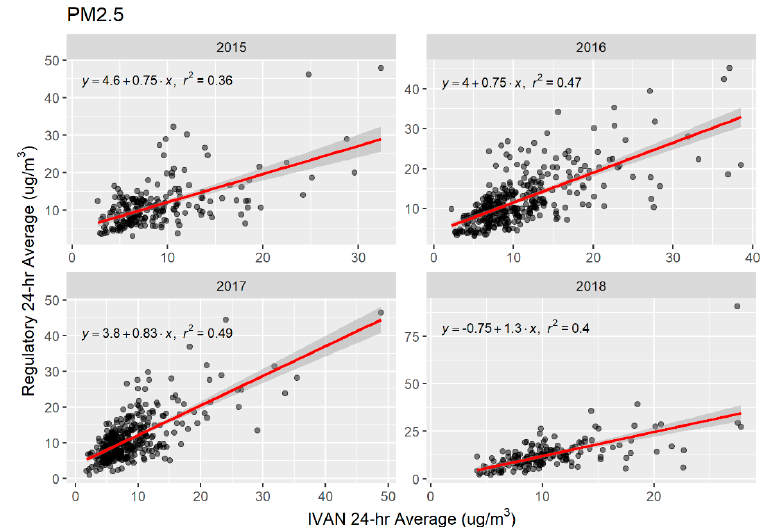
Figure 2. Scatter plots of mean 24-h averages of PM 2.5 from Community Network (IVAN) and regulatory monitors, 2015–2018, by year. OLS simple linear regression lines shown in red with 95% confidence intervals (grey band).